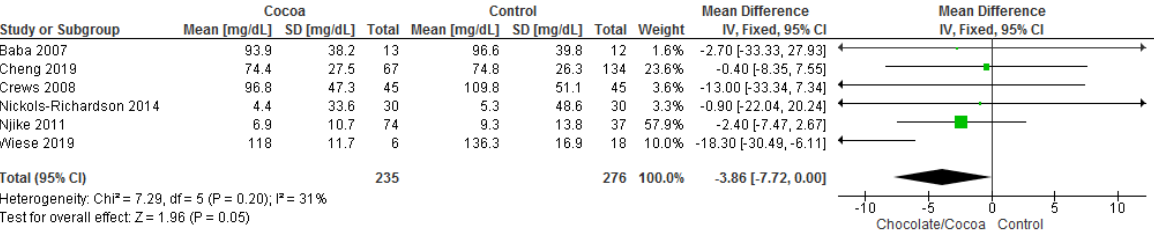
Figure 5. Forest plot of comparison: chocolate versus control, with the outcome - total cholesterol (mg/dL). Figure 6. Forest plot of comparison: chocolate versus control, with the outcome - triglyceride (mg/dL).